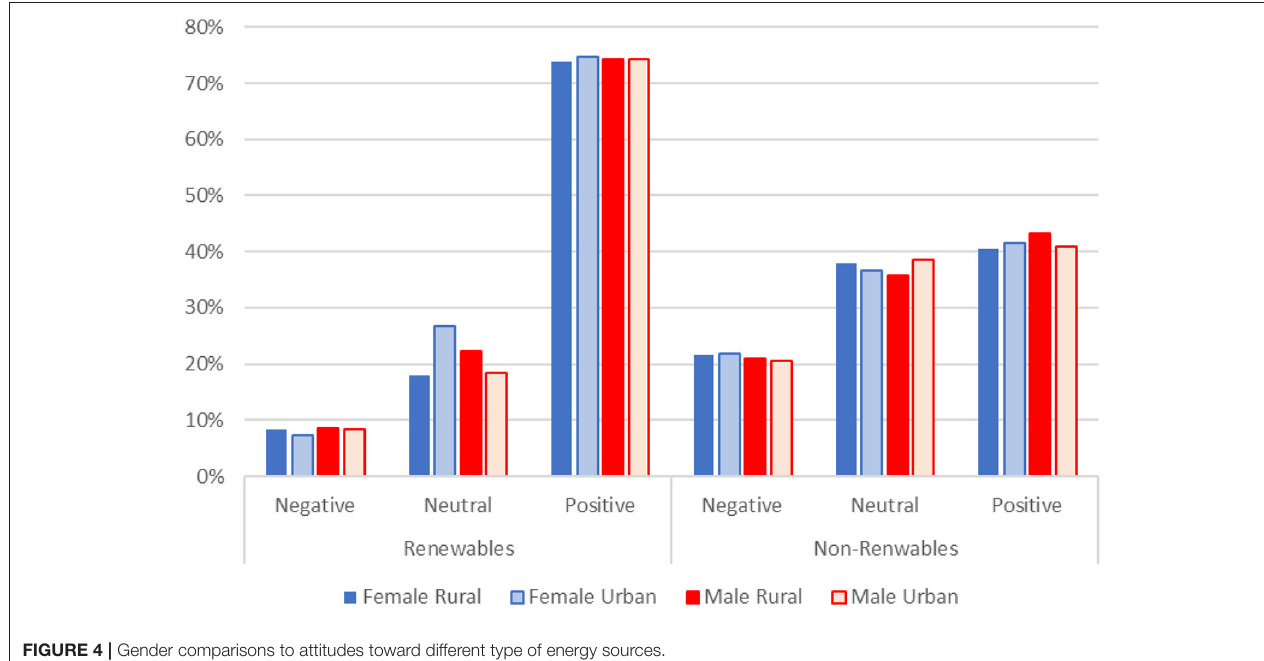
FIGURE 4 | Gender comparisons to attitudes toward different type of energy sources.